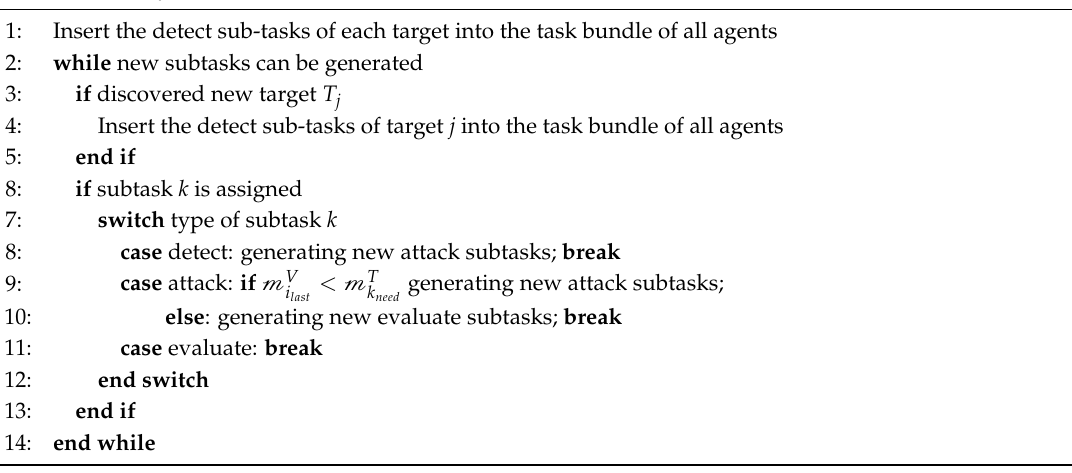
Algorithm 1. Dynamic Task